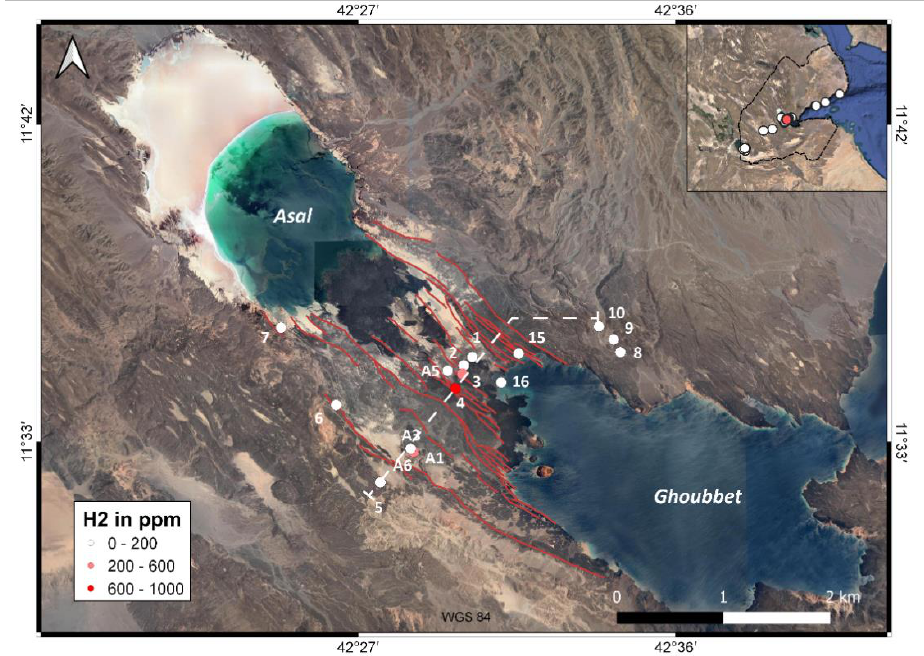
Figure 8. Satellite map of H 2 emanations in the Asal–Ghoubbet Rift. Locations of measurement sites are shown along with their in situ H 2 concentrations (in ppm) before air correction. Inset map illustrates H 2 repartition in the Republic of Djibouti, oriented along a NE–SW axis. Cross-section of the Figure 17 in white